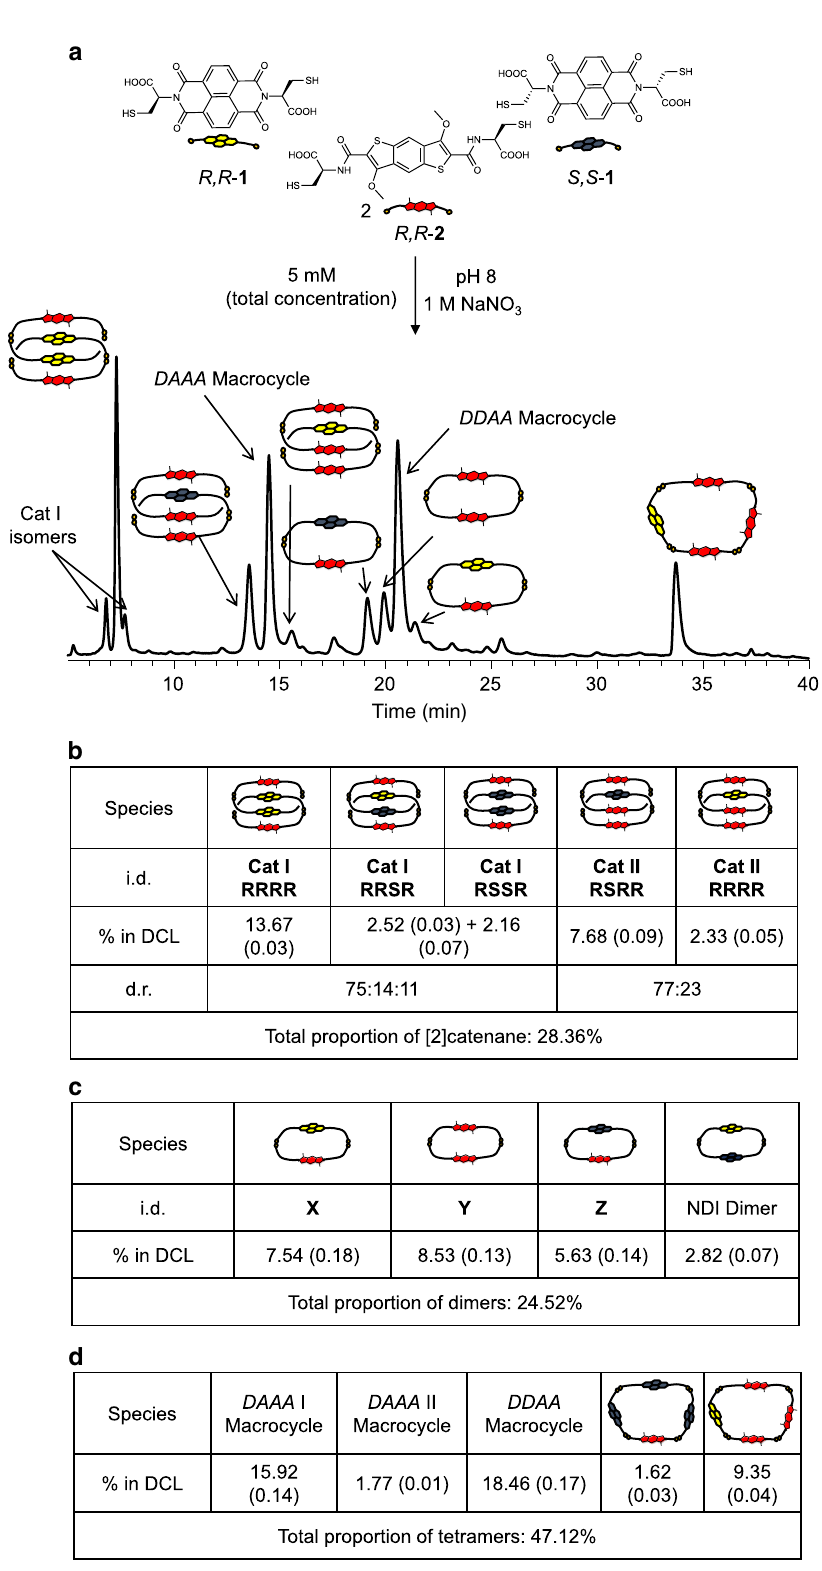
Fig. 1 Racemic DCL. a Reverse-phase HPLC analysis at 389 nm of R,R - 1 : S,S - 1 : R,R - 2 (1:1:2 molar ratio, 5 mM total concentration) library in the presence of 1 M NaNO 3 ; b the table shows the [2]catenanes i.d., percentages, diastereomeric ratios, and the total proportions of [2]catenanes in the DCL; c the table shows the dimers i.d., percentages and the total proportions of [2]catenanes in the DCL; d the table shows the macrocycles i.d., percentages and the total proportions of [2]catenanes in the DCL. The integrations were done in triplicate and the RMSD is reported in parenthesis along with the value. For a complete description of the library, see Supplementary Fig.